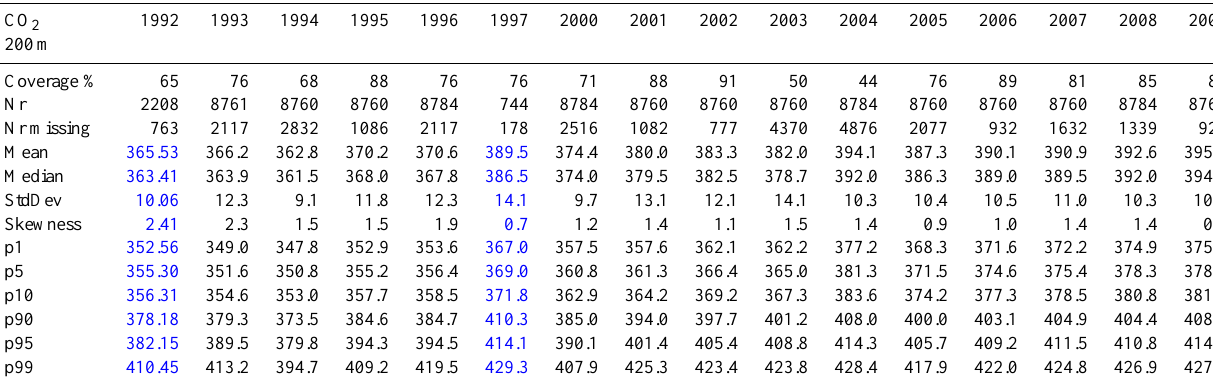
Table 4. Measurement results for CO 2 for the whole observation period. Numbers in blue refer to years with incomplete data because of instrumental failures or start or stop of the observations during that year. All concentrations in ppm. The coverage percentage is not corrected for calibration intervals (4–8%).